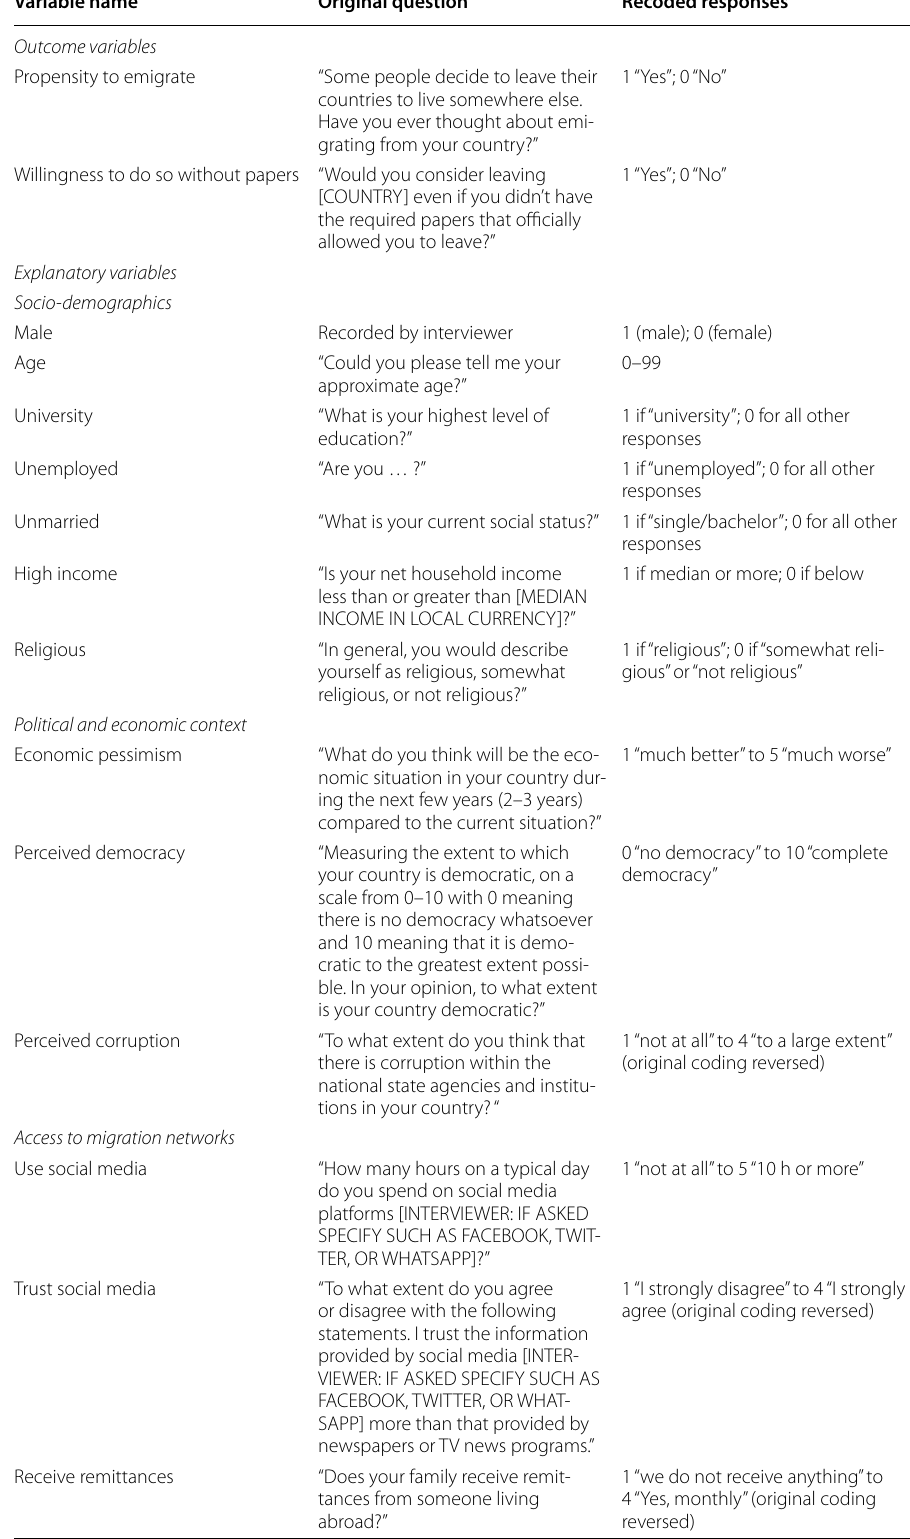
Table 2 Variables used for regression analyses, taken from Arab Barometer Round